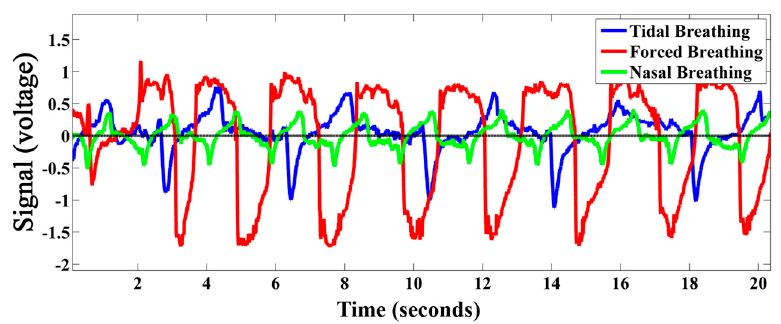
Figure 12. Tidal, forced, and nasal breathing acquired by the developed TBP device.